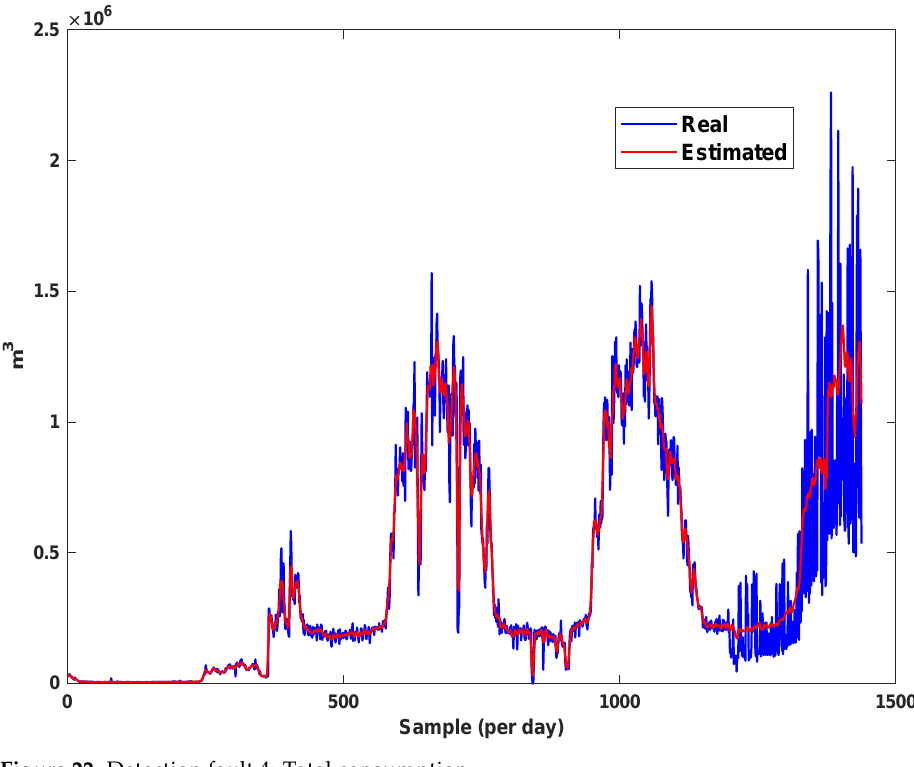
Figure 22. Detection fault 4: Total consumption.